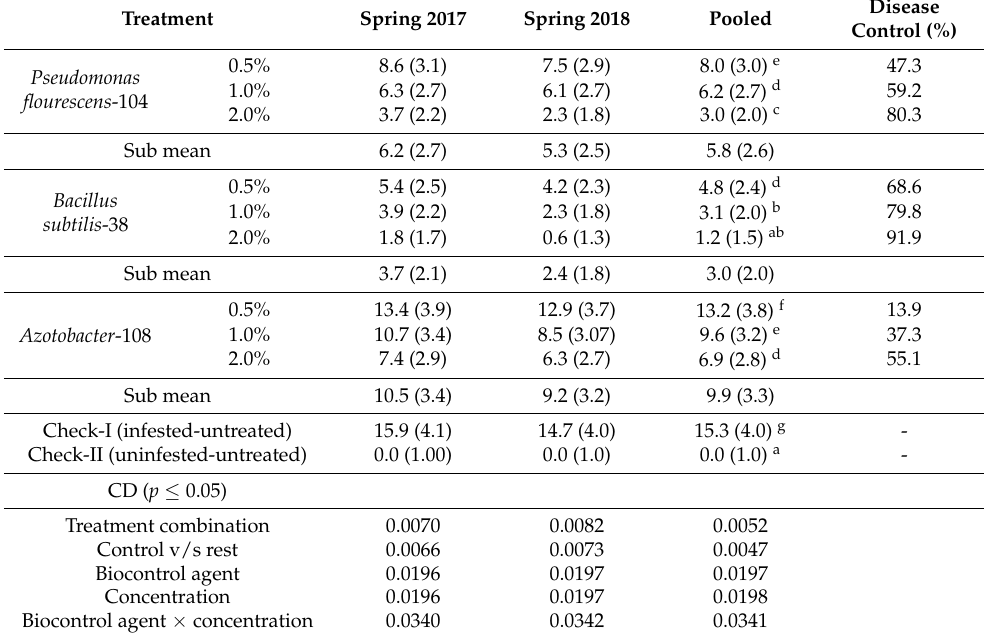
Table 7. In vivo effect of bacterial antagonists on disease severity (%) of green mold of button mushrooms at concentrations between 0.5 and